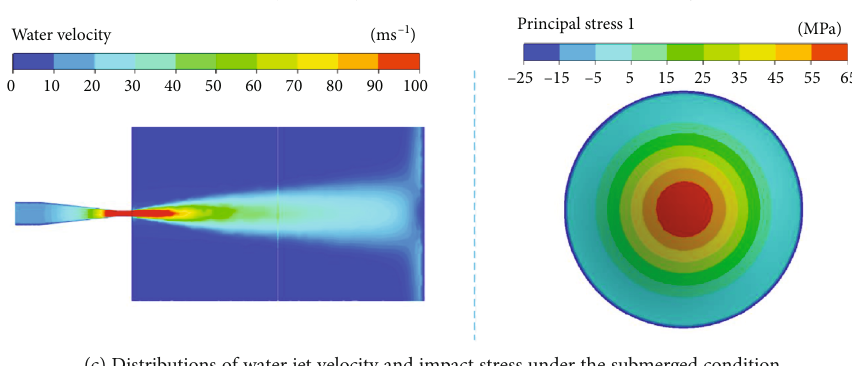
Figure 4: Comparison between jet impact e ff ects under the nonsubmerged and submerged